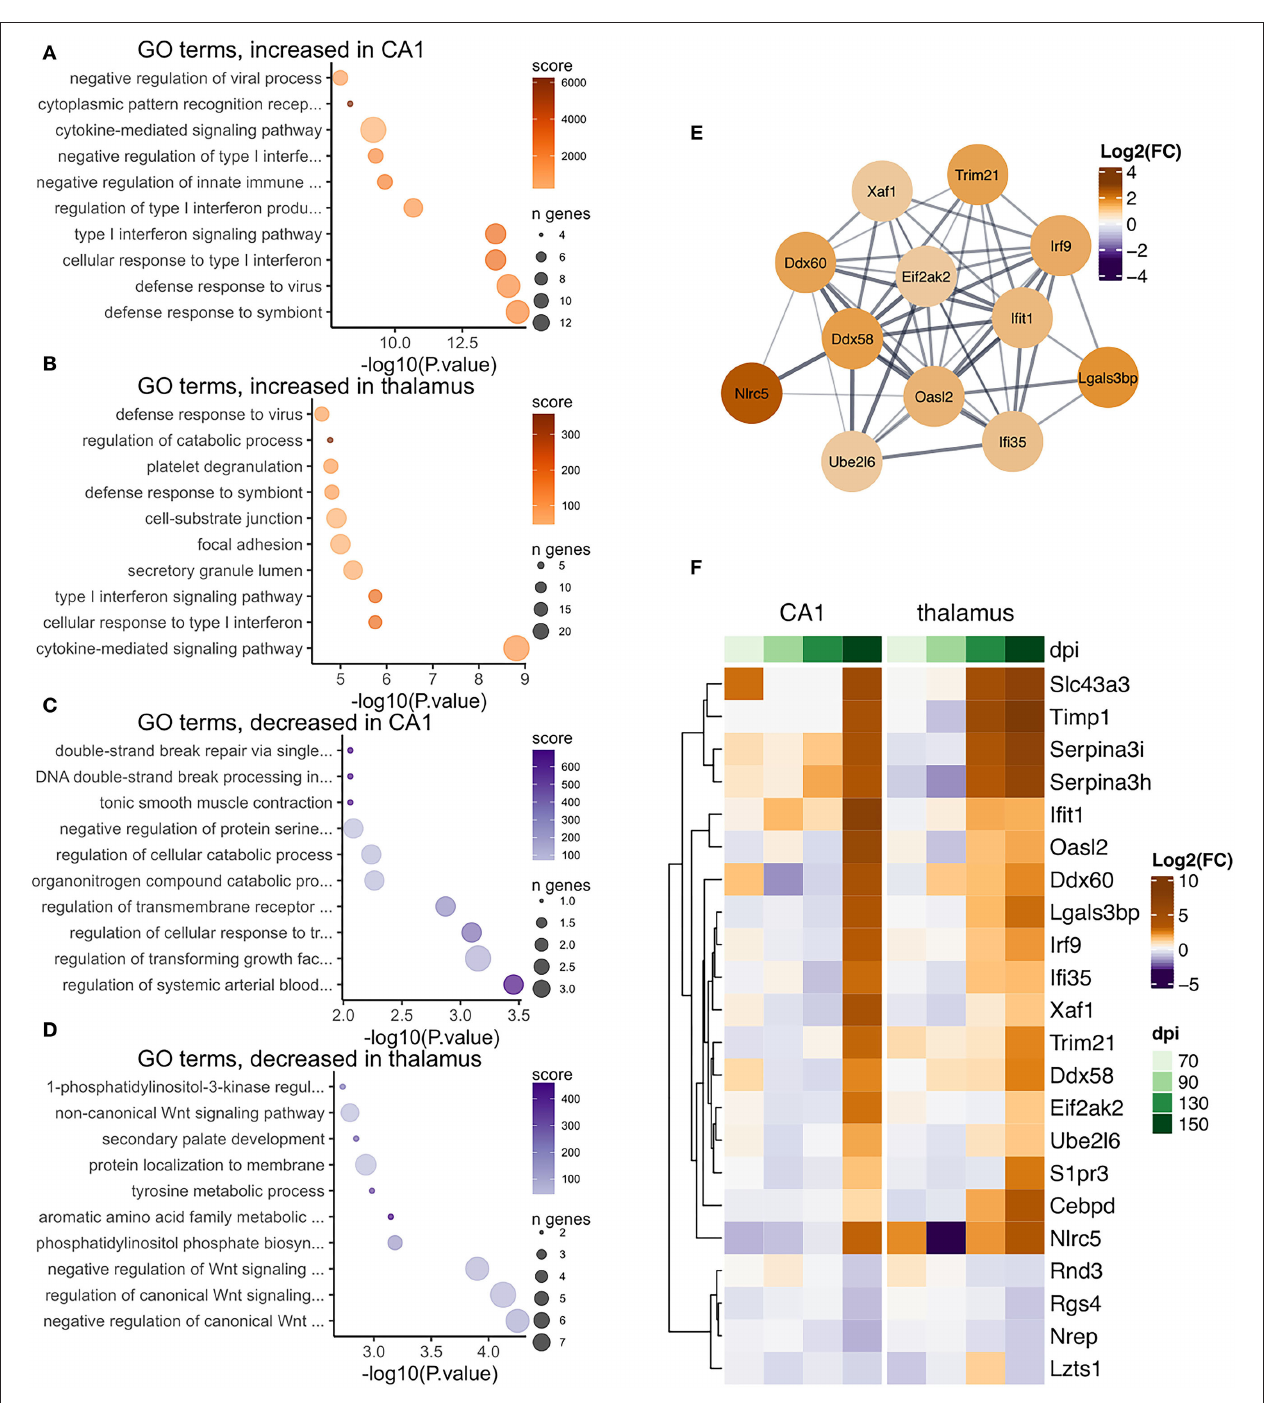
FIGURE 9 | Transcriptional changes affiliated vascular cells in the CA1 and thalamus of RML infected mice. Enrichr was used to identify enriched gene ontologies for vascular affiliated transcripts that were (A) increased in the CA1, (B) increased in the thalamus, (C) decreased in the CA1, and (D) decreased in the thalamus. (E) STRING was used to construct a protein-protein interaction network of the 22 vascular transcripts that were commonly prion altered in the CA1 and thalamus. (F) A heatmap was used to visualize magnitude of change, expressed as log 2 fold-changes at each timepoint for the common vascular